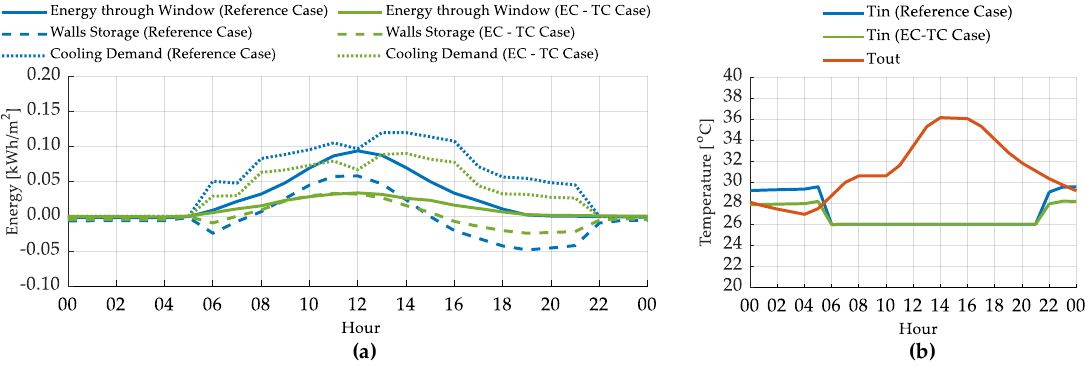
Figure 7. ( a ) Energy balance and ( b ) distribution of the interior and exterior temperature in an office zone with south orientation, on a warm summer day in Athens, for window systems 1 and 4.